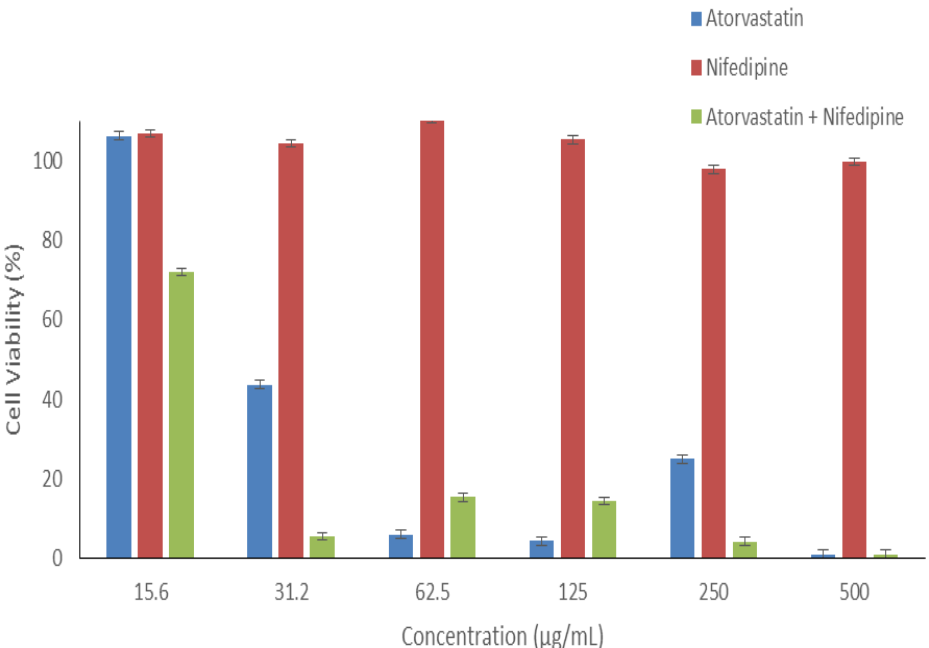
Figure 8. Cell viability of different concentrations of atorvastatin, nifedipine, and their 1:1 combina- tion upon 24 h exposure with HFF- 1 cells. The data showed that nifedipine is safer (≤500 µg/mL) than atorvastatin calcium (<30 μg/mL), while it is only safe <15 μg/mL for the combination—results than atorvastatin calcium (<30 µ g/mL), while it is only safe <15 µ g/mL for the combination—results represented as mean ± SD ( n = 3). represented as mean ± SD ( n =